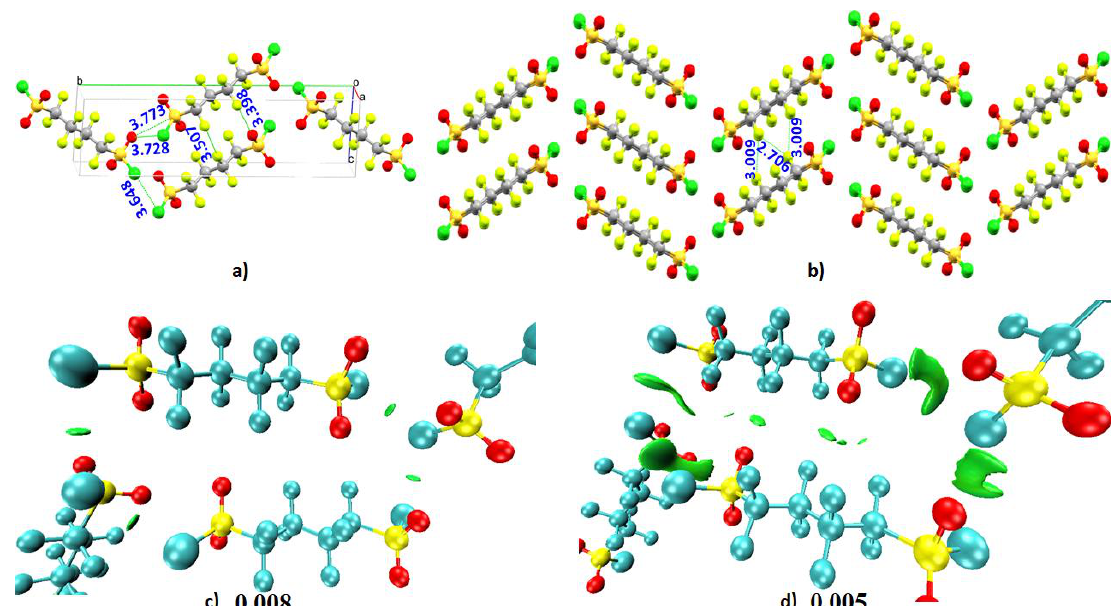
Figure 24. ( a ) The ball-and-stick model of the crystal structure of octafluorobutane-1,4-disulfonyl dichloride (CSD ref: TEWNOB). ( b ) An extended model of the crystal, showing the zigzag array in 3D. ( c ) The IGM isosurface plot, with isovalues of 0.0080 and 0.0050 a.u., illustrating possible halogen-center intermolecular bonding scenarios. Selected bond distances are shown in Å .